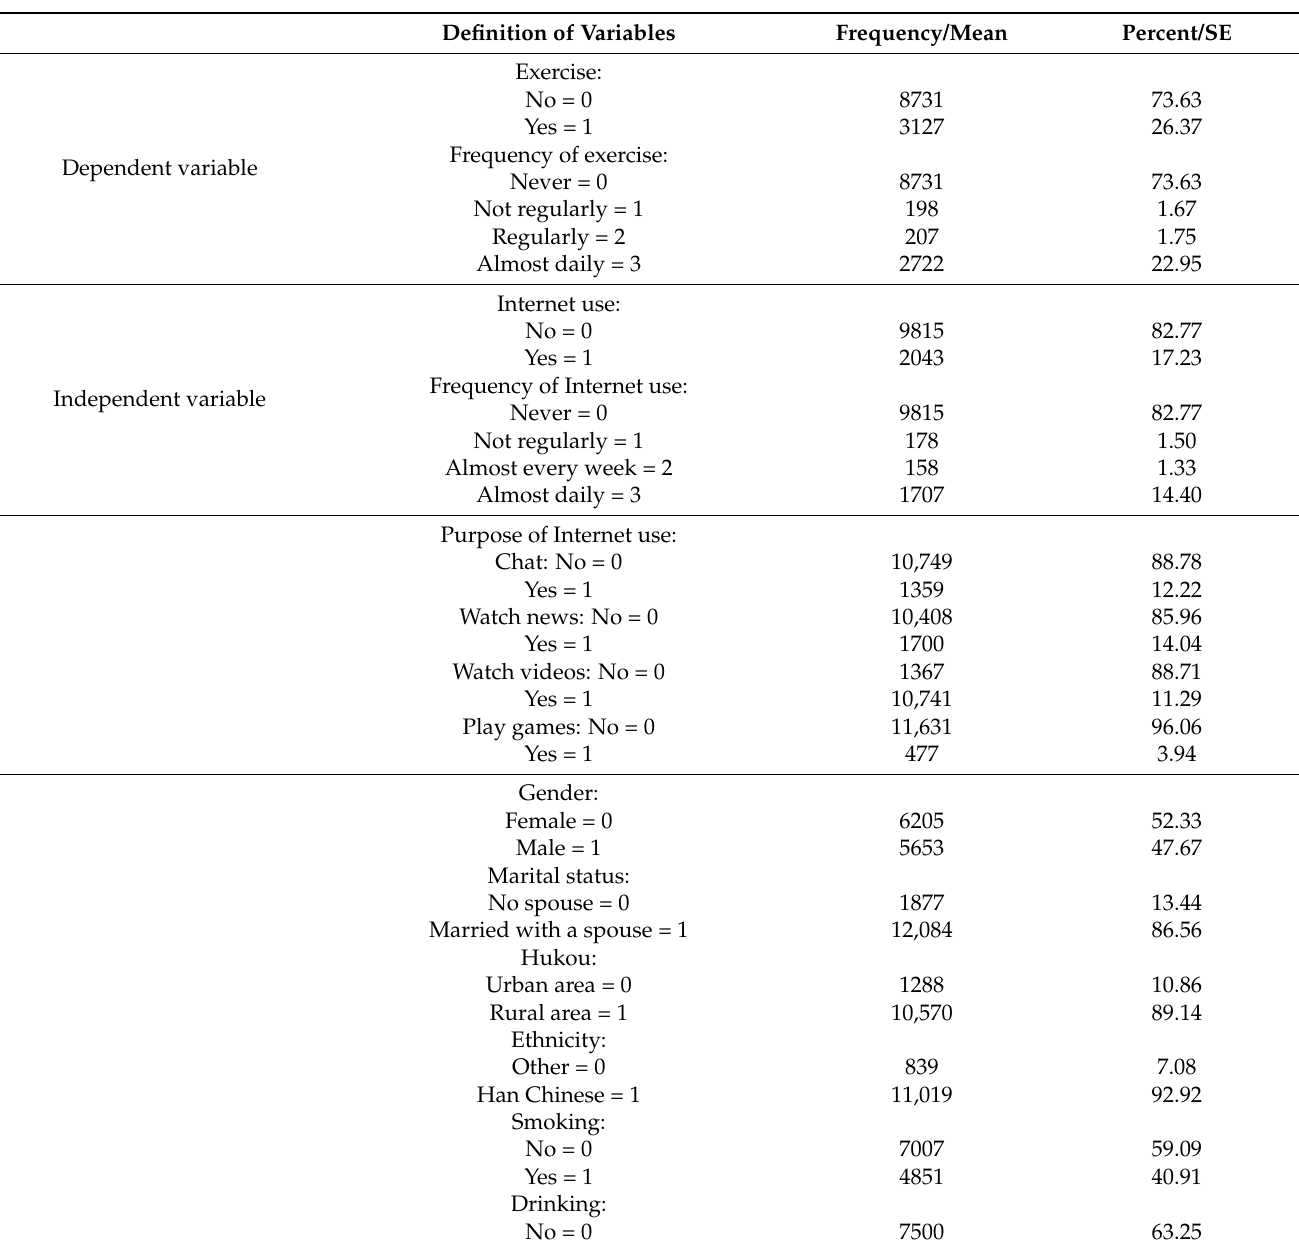
Table 1. Definition of variables and descriptive